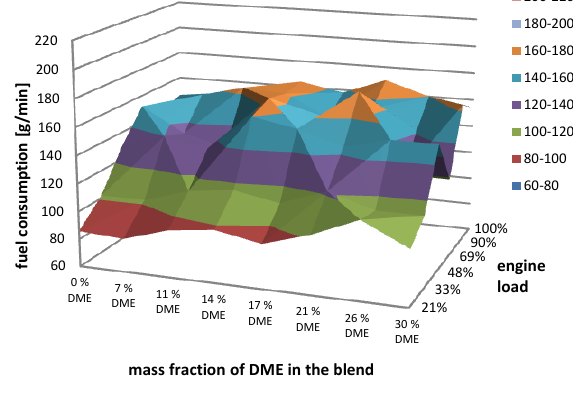
Fig. 4. Fuel consumption [g / min] depending on the percentage of DME and the engine load for the correction of the spark advance 3º